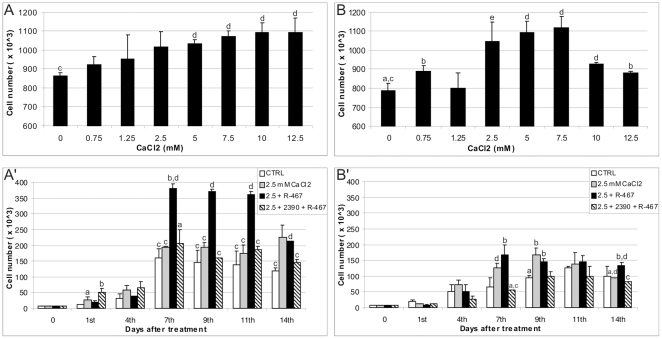
Effects of Ca2+, the calcimimetic NPS R-467 and the
CaSR antagonist NPS2390 on eUCM-MSC growth.Cells were plated in 6-wells plates and treated as described in materials
and methods. Effects of increasing doses of extracellular
Ca2+ on both, large (A) and small (B), cell lines.
In the large cell line (A'), increasing Ca2+
concentration to 2.5 mM was not effective on cell growth. In the
presence of 2.5 mM Ca2+, the allosteric activator of the
CaSR, NPS R-467 (3 µM) significantly increased the cell
number/well from day 7th after treatment (P<0.001). In the
small cell line (B'), increasing Ca2+ concentration
induced cell growth on day 9th (P<0.05). In the presence
of 2.5 mM Ca2+, the allosteric activator of the CaSR,
NPS R-467 significantly increased the cell number/well on day
9th (P<0.05). In both cell lines, 30 min preincubation
in presence of the CaSR antagonist NPS 2390 (10 µM) significantly
inhibited the agonist effect. Results are mean ± SD of 2 data
points. Student's t Test: a vs b: P<0.05; a vs e: P<0.01; c
vs d P<0.001.